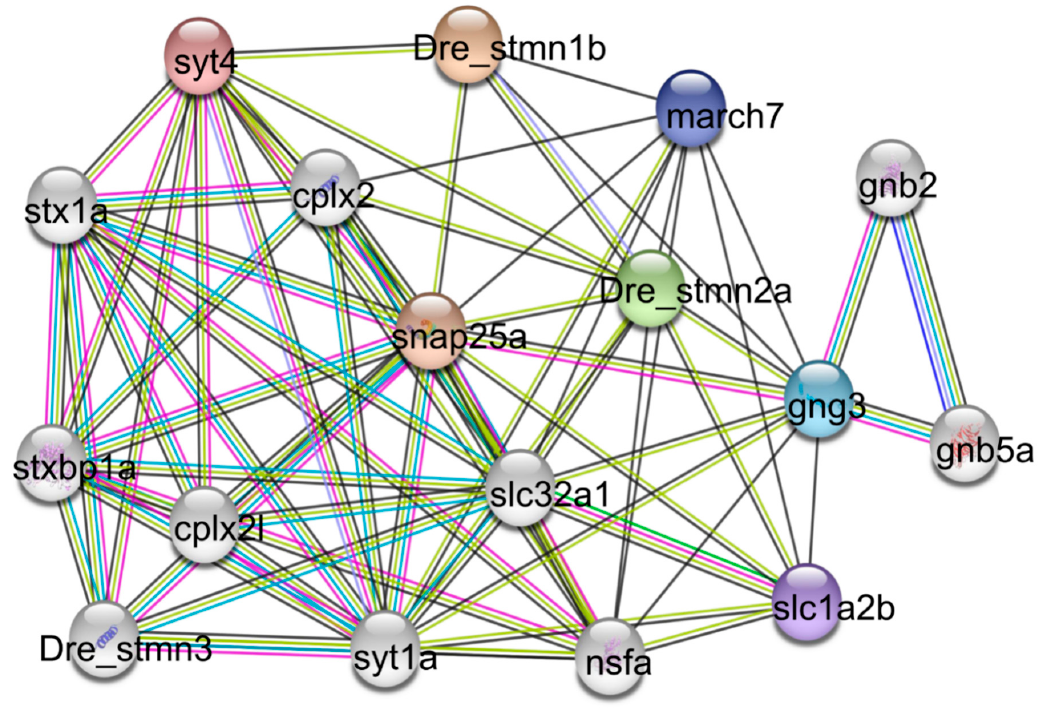
Figure 6. Functional network assembly of the zebrafish stathmin genes. Seventy-four interactions exhibited among a total of 17 were exhibited among a total of 17 genes.